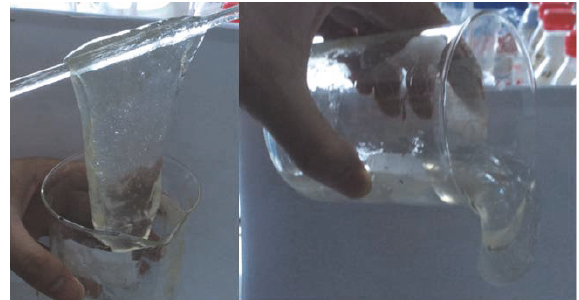
Figure 6: Cross-linking of guar with 20000 ppm NaCl (Sample TI- 1).